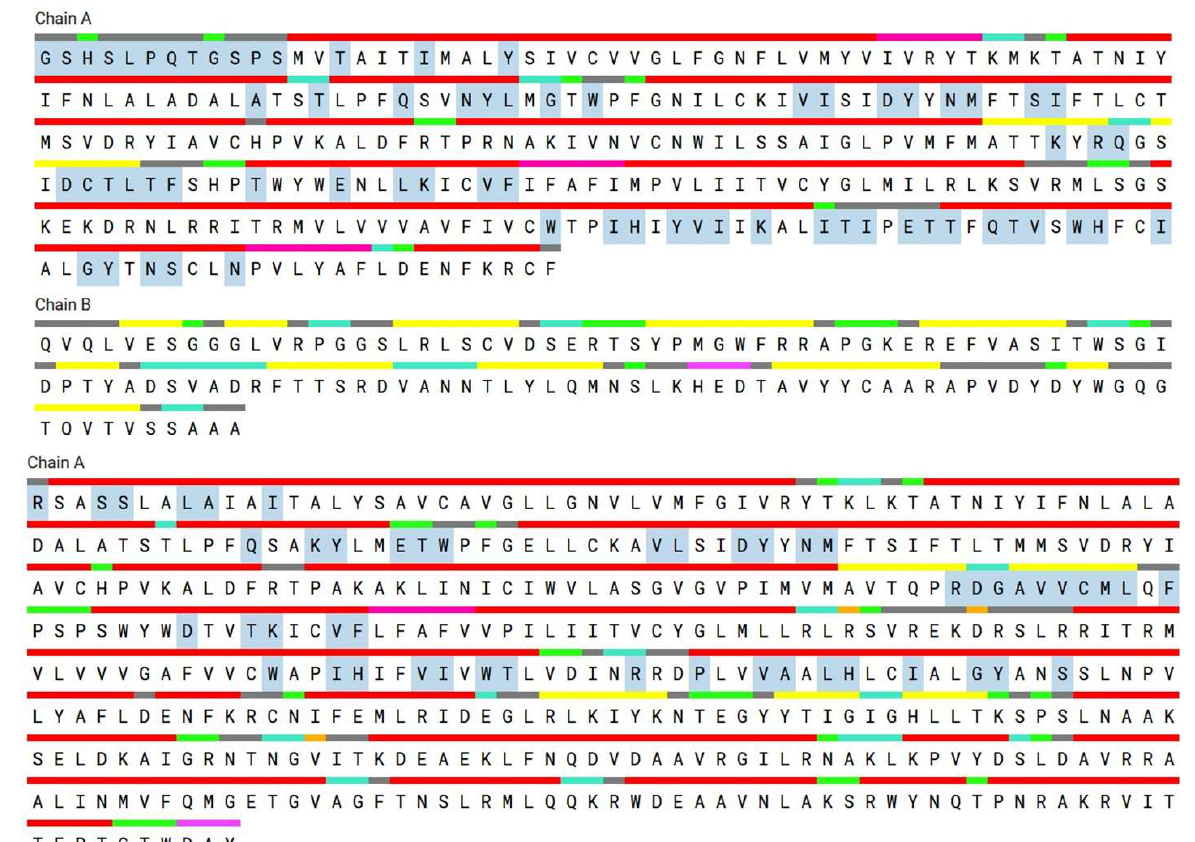
5C1M) and deltaOR (δOR, PDB ID: 4EJ4). The binding energy is negative for the examined is −9.7 kcal/mol, whereas that of compound 1 to the 4EJ4 is −7.1 kcal/mol, demonstrating significant inhibitory capacity. Compound 2 (quercetin) (Figure 2B) shows the best bind- ing energy of −8.5 kcal/mol against the δOR 4EJ4 receptor, while −8.1 kcal/mol against the µOR 5C1M receptor. Compound 3 (violanthin) (Figure 2C) shows high binding energy of −9.5 kcal/mol against the 5C1M receptor and −7.9 kcal/mol against the 4EJ4 receptor. The stability in ligand binding is greatly aided by hydrogen bonding, and the maximum ac- ceptable bond gap between H acceptor and H donor atoms is 3.5 Å [13]. Two hydrogen bonding interactions exist between compound 1 and the 5C1M receptor (Figure 3A). Bond lengths of 1.49 and 1.46 indicate a hydrogen connection between the His54 and Gln124